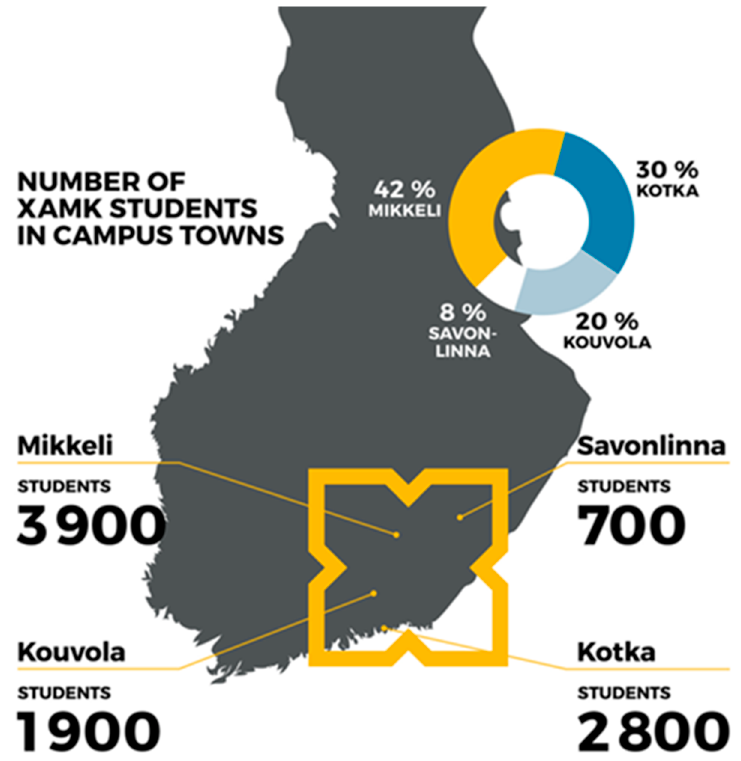
Figure 2. South-Eastern Finland University of Applied Sciences, an organization with geographical challenges (Xamk 2018).